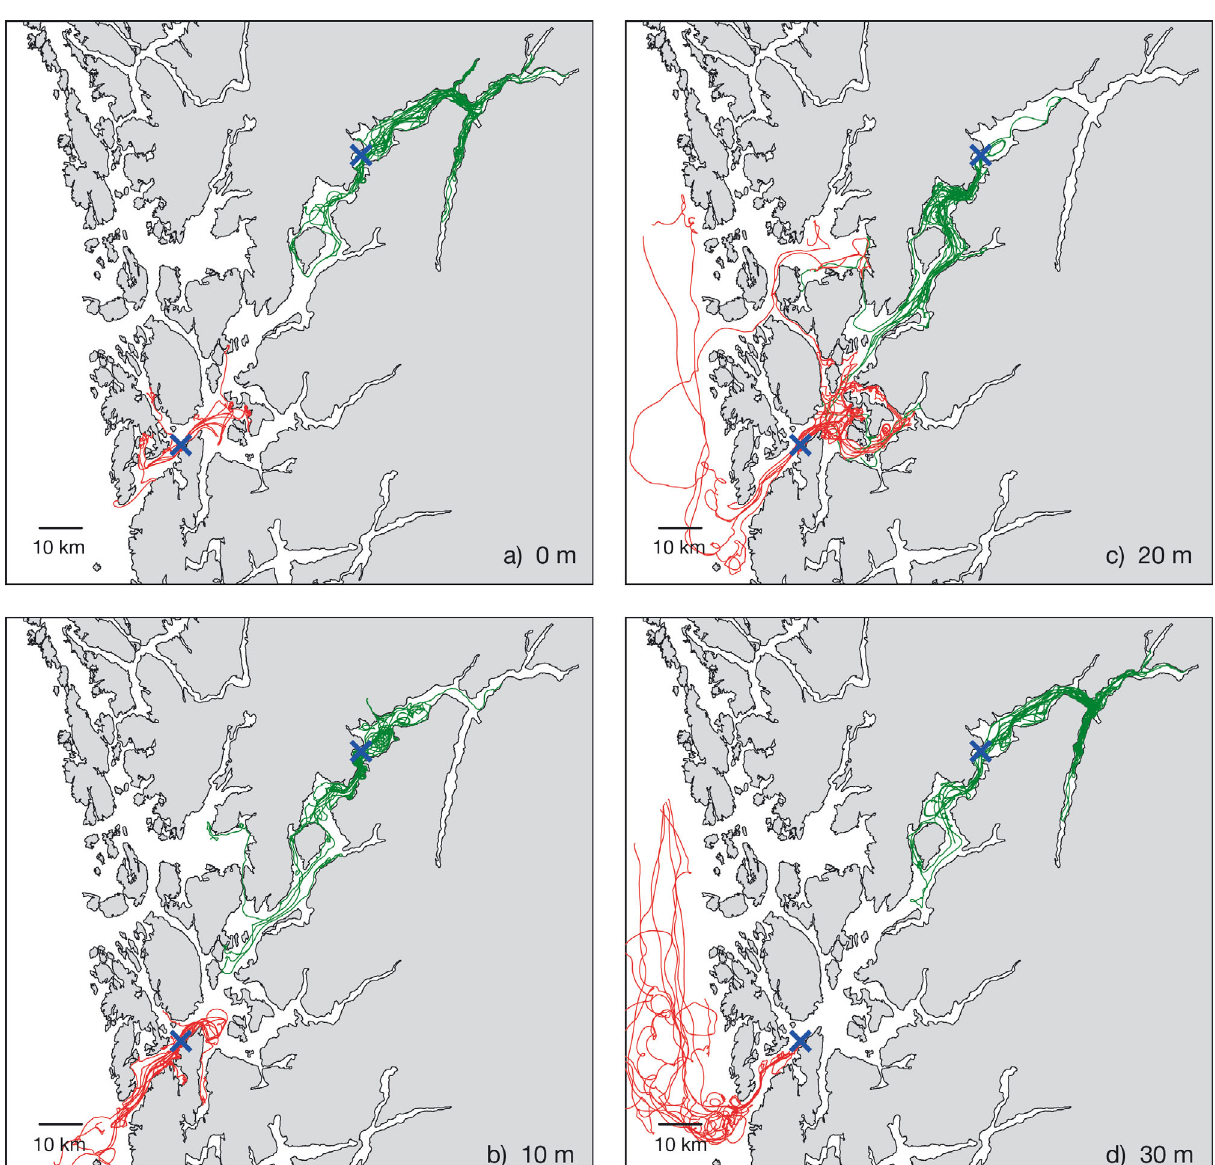
Fig. 5. Trajectories of 10 particles (simulated Lepeophtheirus salmonis in planktonic stages) released and fixed at (a) 0 m, (b) 10 m, (c) 20 m and (d) 30 m depths at 2 positions in the Hardangerfjord. The simulated period is 1−30 May 2009, based on cur- rent fields from the 200 m resolution fjord model. Blue crosses: release locations of particles; red trajectories: particles released at the outer position; green trajectories: particles released at the inner lease position, with a mean travel distance of 15 and ticles at 30 m depth were transported effectively out of 26 km, respectively (Fig. 5a,b). The relatively short the fjord and to the north along the coast, resulting in transport of the particles was due to wind-driven the greatest transports, with a mean value of 57 km cross-fjord currents close to the surface accumulating from their release position (Fig. 5d). Simulations were the particles along the shoreline. Particles fixed at the re peated for a re lease of 20, 30, 50 and 100 particles at same depths released at the inner position were not every depth, as a sensitivity test. The simulations forced towards land to the same extent. The trajecto- showed different particle trajectories due to stochas- ries of particles released from the outer position at 20 ticity in the dispersal. The variance was largest for the m depth covered a large area in the fjord, with a mean particles at the surface, decreasing for particles at transportation of 32 km from the source (Fig. 5c). Par- deeper depths. Neither the mean transportation of